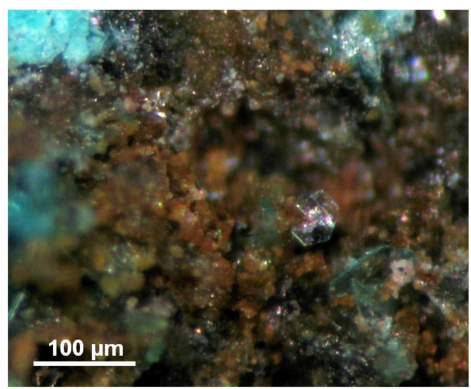
Figure 1. Tiberiobardiite, thin, pseudo-hexagonal crystals, up to 40 µ m in size, with iron oxides. Cretaio, Prata, Massa Marittima, Grosseto, Tuscany. Holotype specimen, #19900, collection of the Museo di Storia Naturale of the University of Pisa.